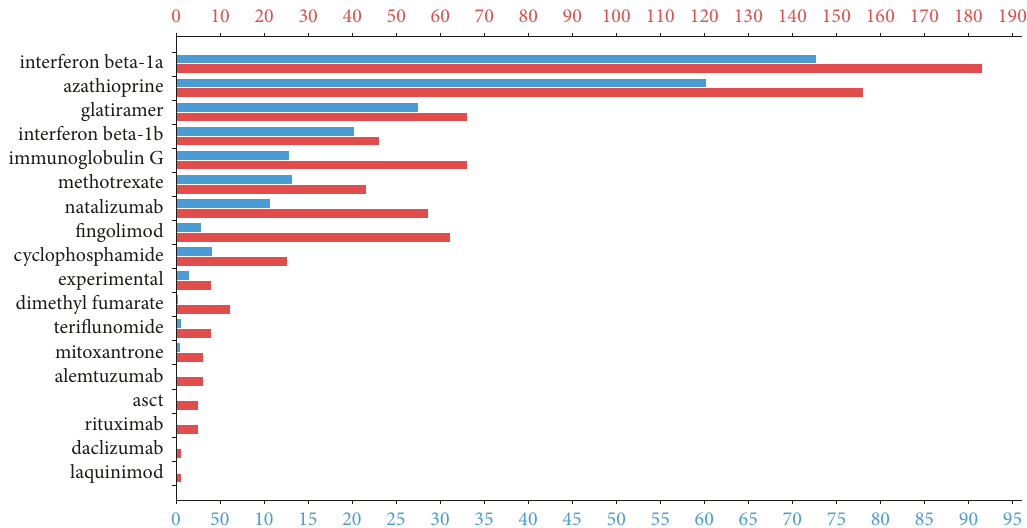
Figure 2: Total number of patients and total treatment duration in years by single drugs. Blue bars indicate the total number of patients ever exposed to each drugs during the follow-up; red bars indicate the cumulative treatment time for each drug.